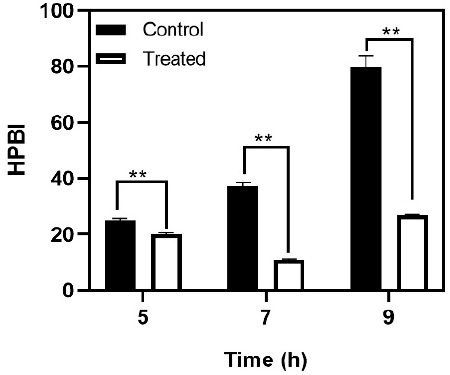
Figure 3. Effect of baicalein on S. mutans cell surface hydrophobicity. Student t-test was used for analysing significance and p < 0.05 was considered significant. * denotes p ≤ 0.05, ** denotes p ≤ 0.01 and *** denotes p ≤ 0.001.